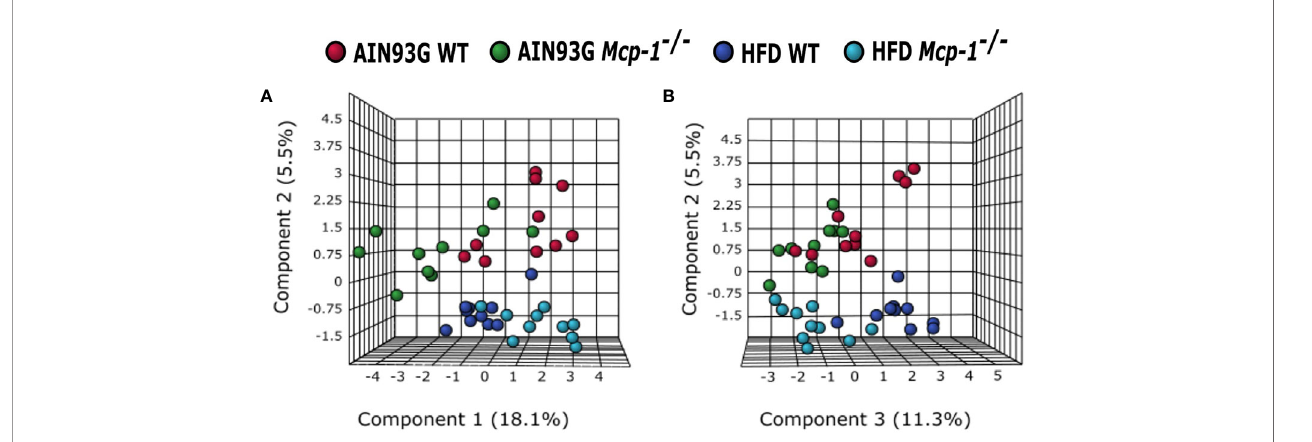
FIGURE 5 | Sparse partial least square discriminant analysis of the plasma metabolome among the four dietary groups. (A) Components 1 vs 2; (B) Components 2 vs 3. AIN WT (red): wild-type mice fed the AIN93G diet; AIN Mcp-1 -/- (green): Mcp-1 -/- mice fed the AIN93G diet; HFD WT (blue): wild-type mice fed the high-fat diet;